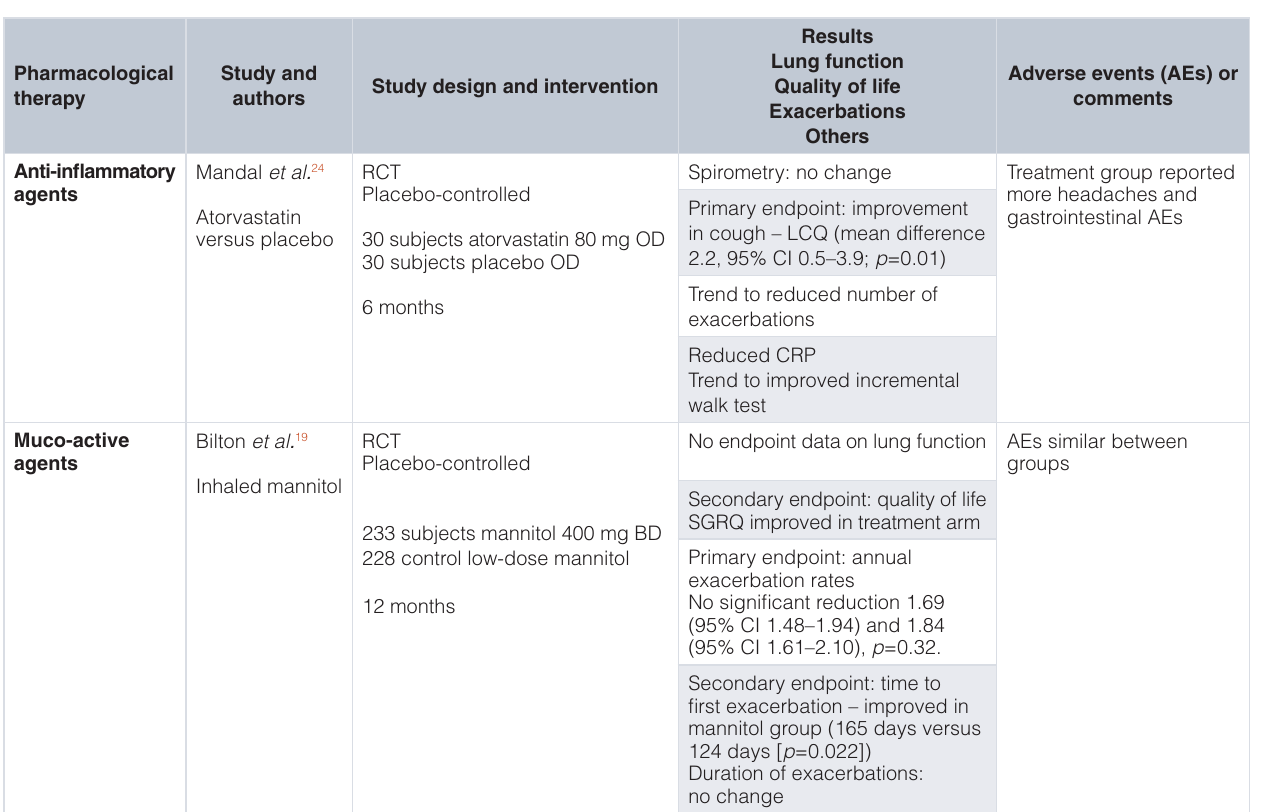
Table 2. Randomised controlled trial (RCT) on anti-inflammatory and muco-active